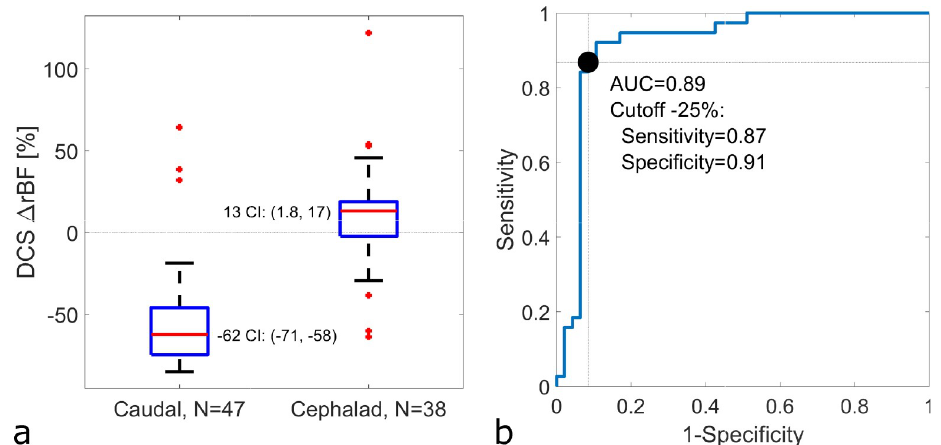
Fig 7. Blood flow changes in spinal cord regions cephalad and caudal to aortic occlusion at multiple positions and repetitions. No correction for multiple measurements in the same pig (N = 5). (a) Blood flow below the site of aortic balloon inflation fell -62% (95% confidence interval, CI: -71, -58%) from baseline, while blood flow above the aortic occlusion increased 13% (1.8, 17%) from baseline, rejecting the null hypothesis at a significance of 0.05 that the blood flow below the balloon site did not change (i.e., Δ rBF = 0). The respective interquartile ranges for the caudal and cephalad measurements were [–75–46] % and [–2 18] % respectively. (b) Receiver operating characteristic curve of the ability of DCS flow to predict the placement of the aortic balloon cephalad to the DCS sensors, including sensitivity (0.87) and specificity (0.91) calculated for a cutoff of Δ rBF = -25% to detect an aortic occlusion cephalad to the sensor location (S1